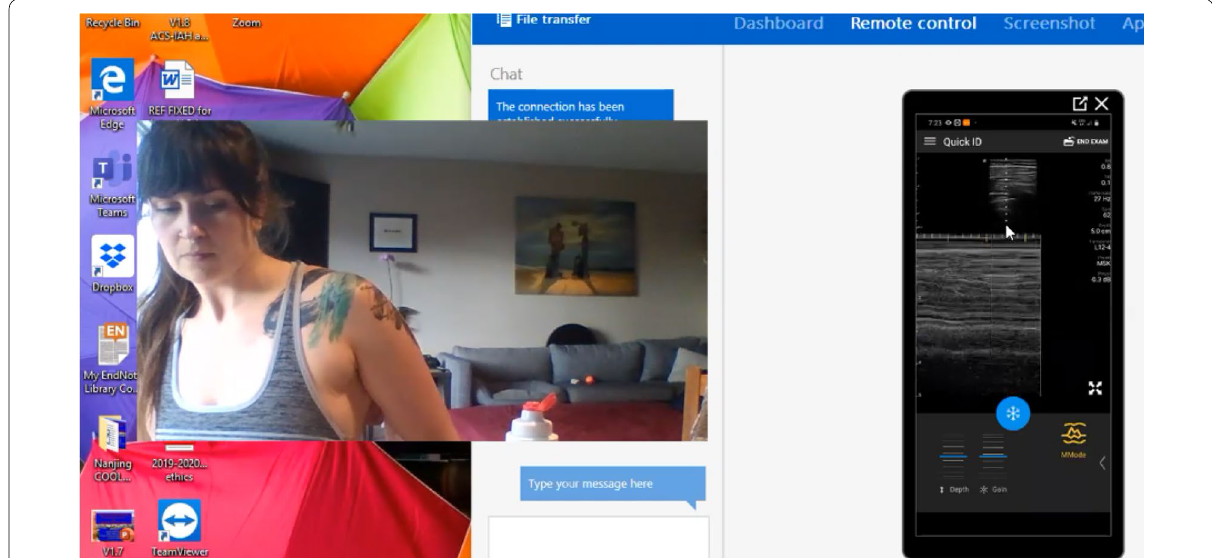
Fig. 3 Representative still image of mentee self-performing lung ultrasound to demonstrate the pleural interface of her back. Ultrasound Naïve participant being instructed to demonstrate the pleural interface of the visceral and parietal pleural illustrating the “Seahorse” sign of Lichtenstein [20]. It should be noted that all lung ultrasound is a dynamic examination better viewed real time and in video recordings (Additional file 3) than